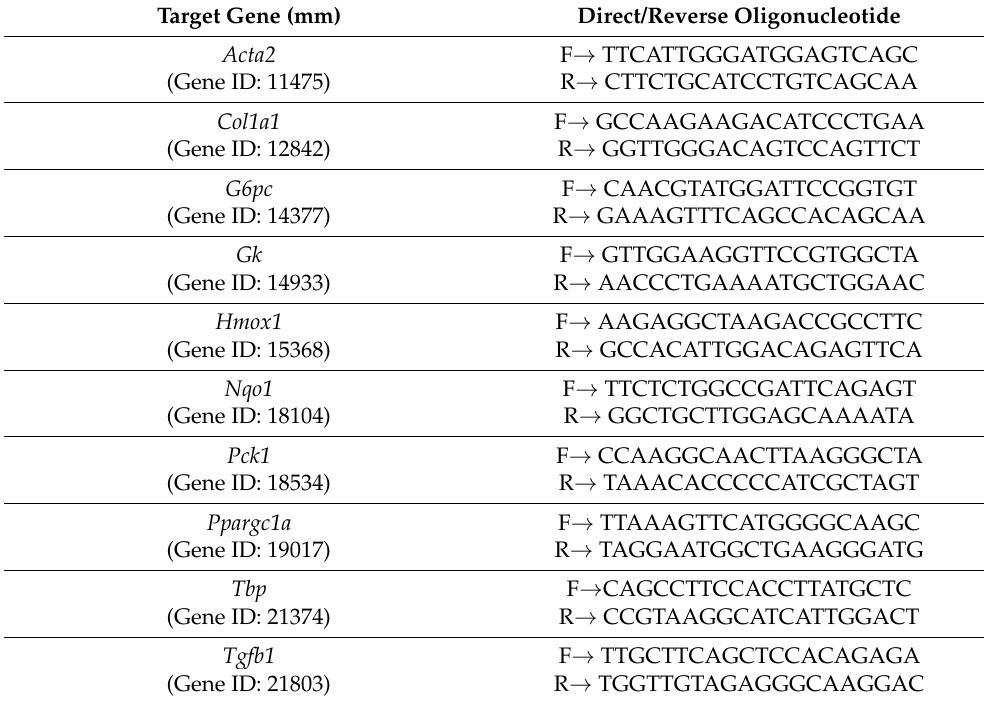
Table 1. The oligonucleotides used for RT-qPCR.